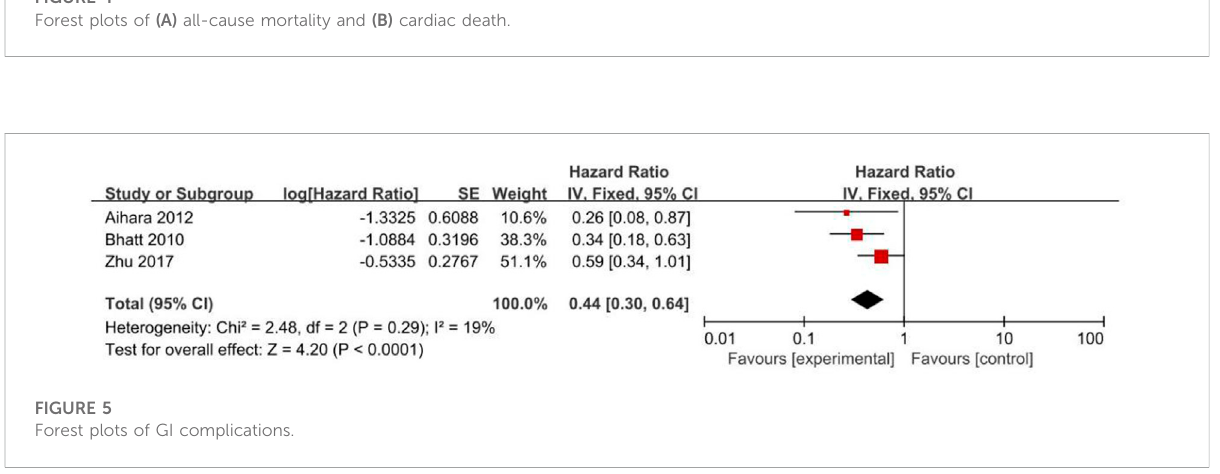
FIGURE 5 Forest plots of GI